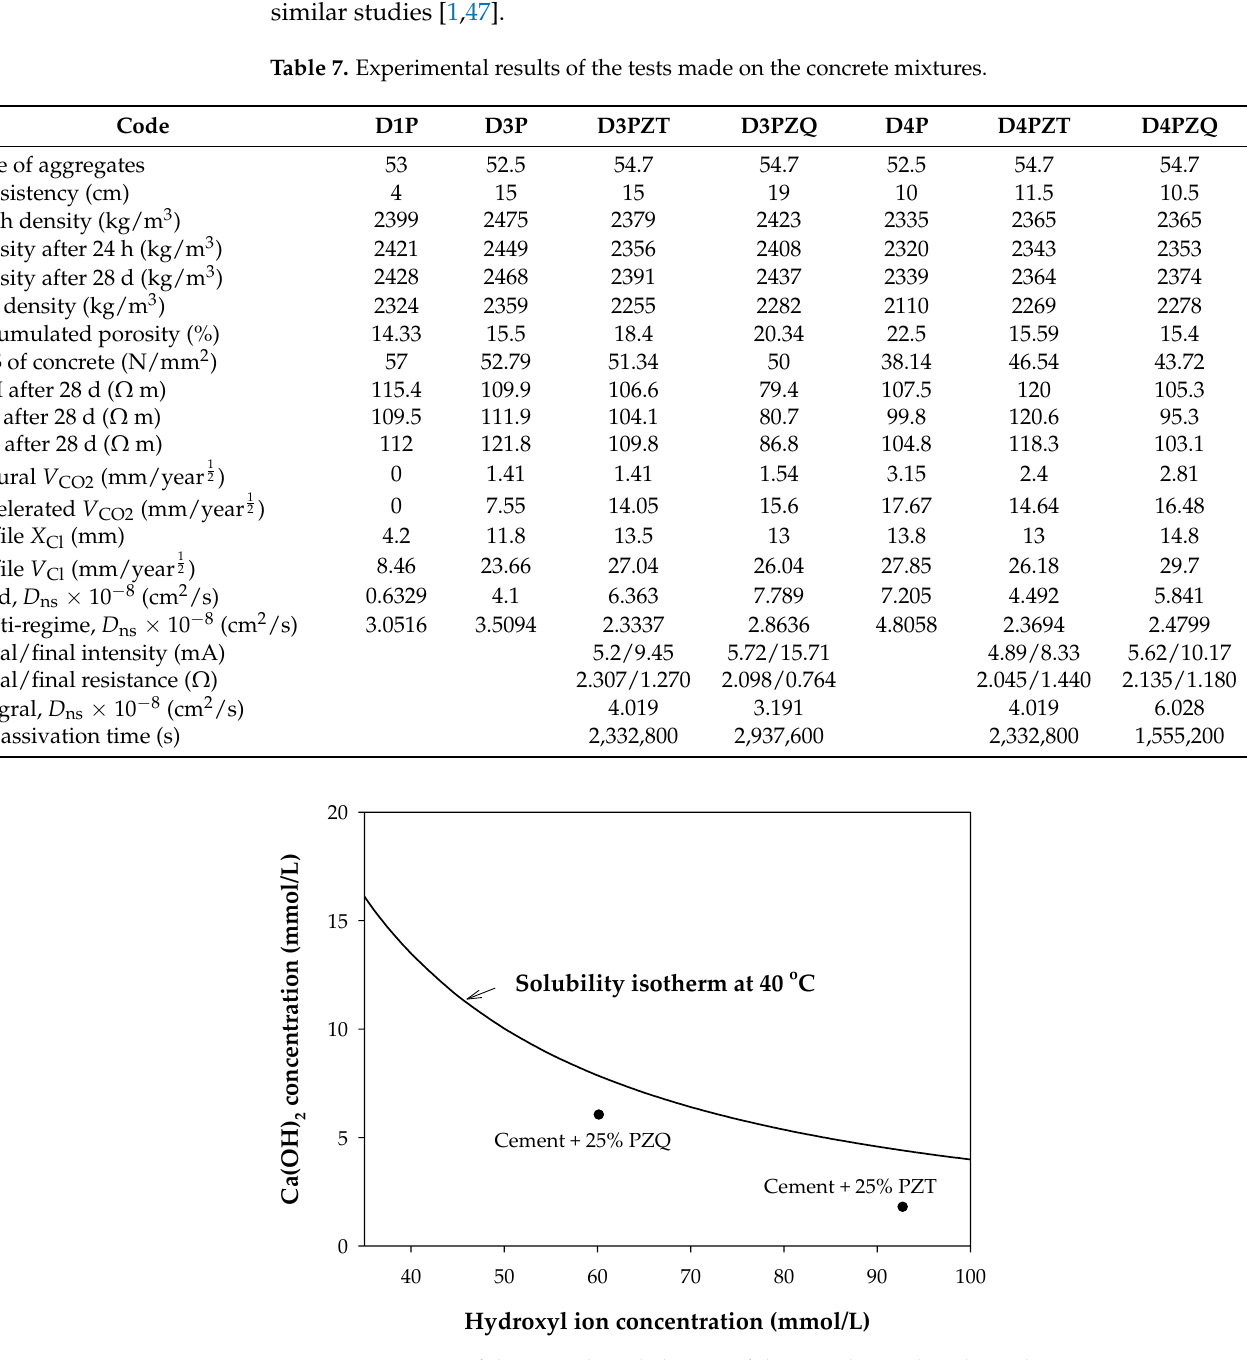
Figure 5. Variation of the pozzolanic behavior of the samples analyzed at 7 days. The additions of PZT and PZQ give concretes whose strengths correspond well to those required for concrete HA-25 (dosages D4) and HA-30 (dosages D3). When these are added to replace superfine aggregate, the pozzolan tuff shows increases of 22% and poz- zolan quarry of 5% over the reference mix. When added as a replacement for cement, they cause a small decrease in resistance. All mixes exceed the required minimum characteris- tic strengths of 25 N/mm 2 and 30 N/mm 2 , respectively. The dosages with the two pozzo- lans far exceed the limit of 75% of the resistant activity index with respect to the reference cement according to the UNE EN 196-1 standard. These results are in agreement with similar studies [1,47].